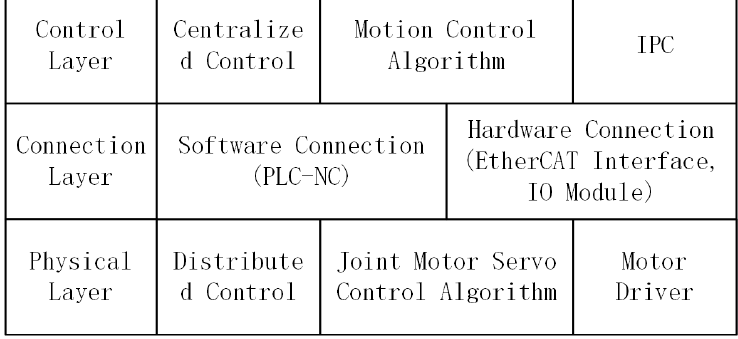
Figure 5. Dual-arm puncture system control